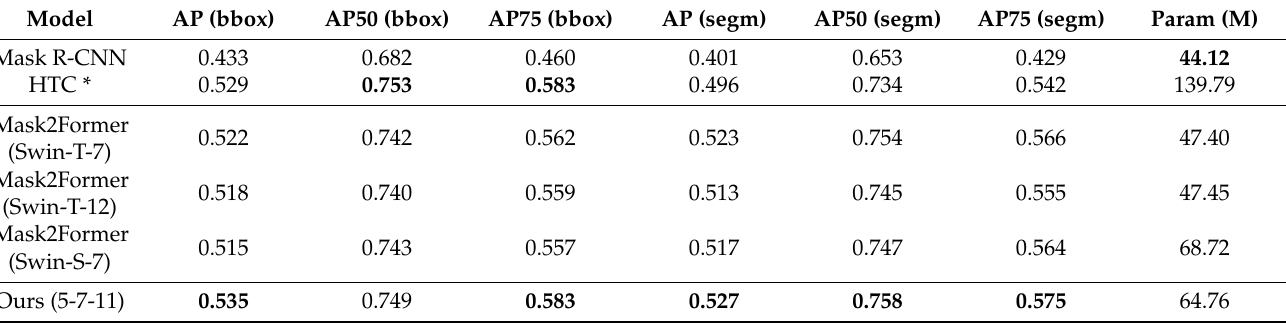
Table 1. Instance segmentation results on the validation set. Our model is superior to the baseline for most of the